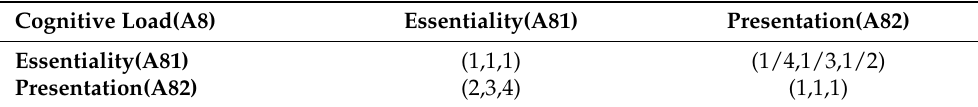
Table 12. Fuzzy based comparison matrix associated with the sub-criteria in relation to the cognitive load (A8) criteria.